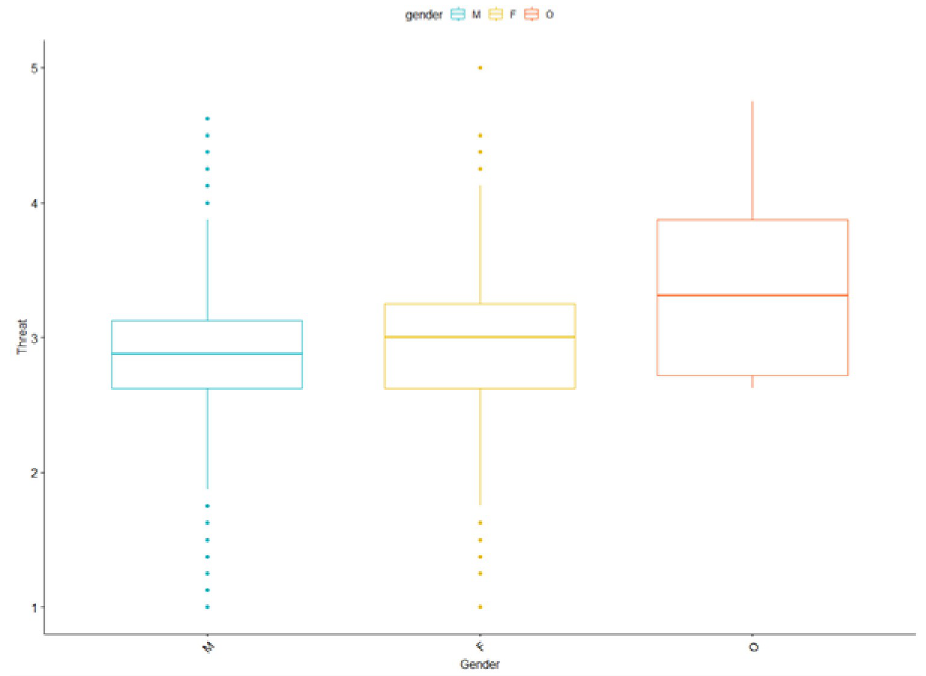
Fig 11. Levels of perceived threat by gender.